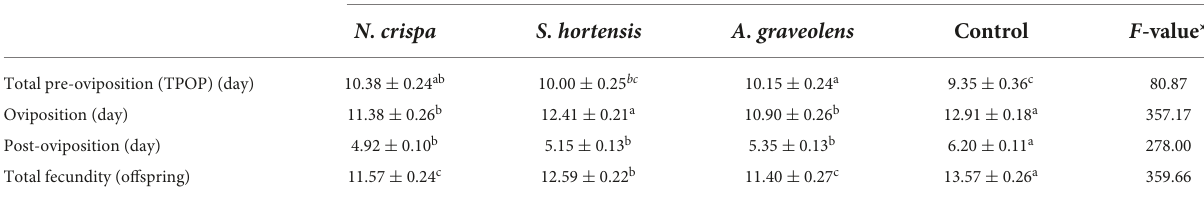
TABLE 4 Mean ( ± SE) reproductive period and total fecundity of offspring from females of A. swirskii from control and treatments with N. crispa , S. hortensis , and A. graveolens oils.